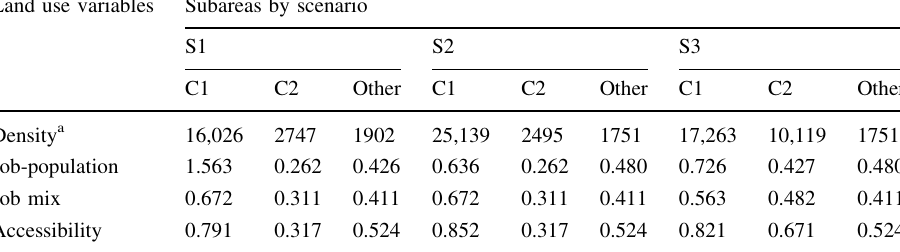
Table 2 Statistics of land use patterns for each scenario